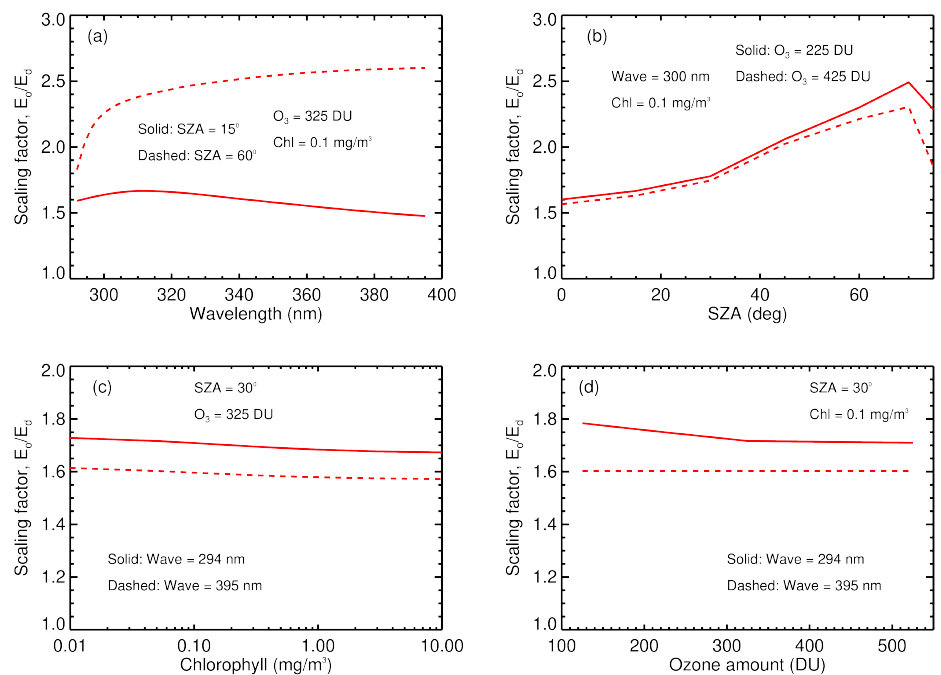
Figure A2. The scaling factor dependence on different variables; ( a ) the f dependence on wavelength for different SZAs; ( b ) the f dependence on SZA at 300nm for different ozone amounts; ( c ) the f dependence on chlorophyll concentration for different wavelengths. ( d ) The f dependence on ozone amount for different